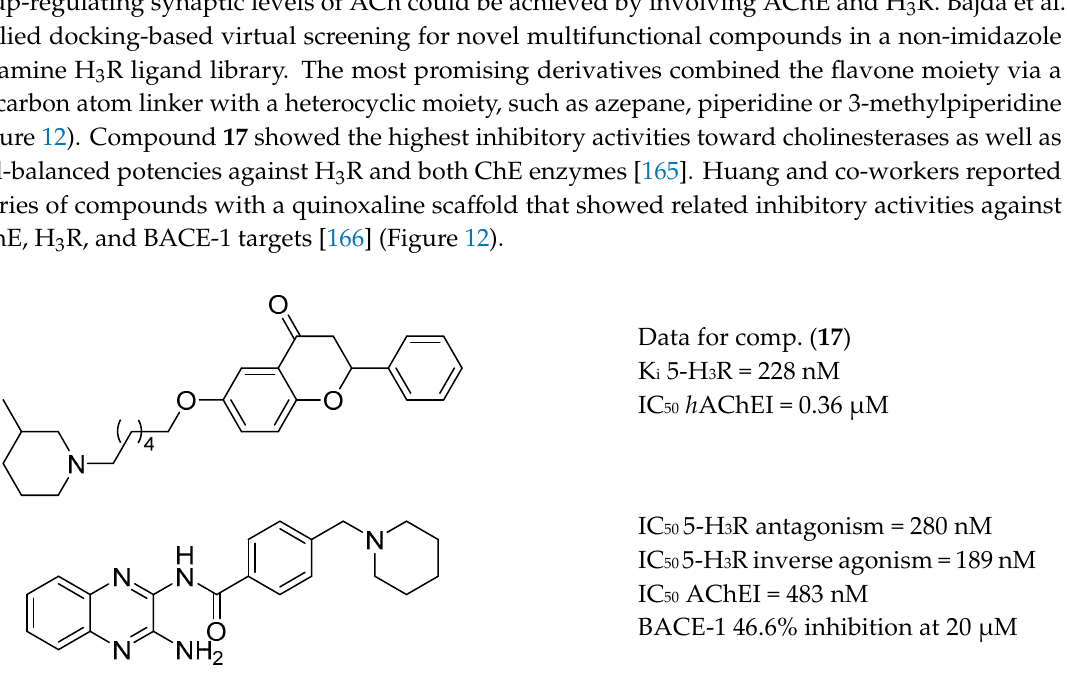
Figure 12. Hybrid involving AChE and H 3 R from [166] and [167].